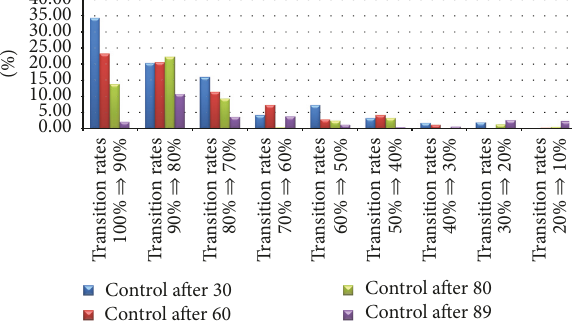
Figure 10: Reduction in receiving caused by user transition rates changing.